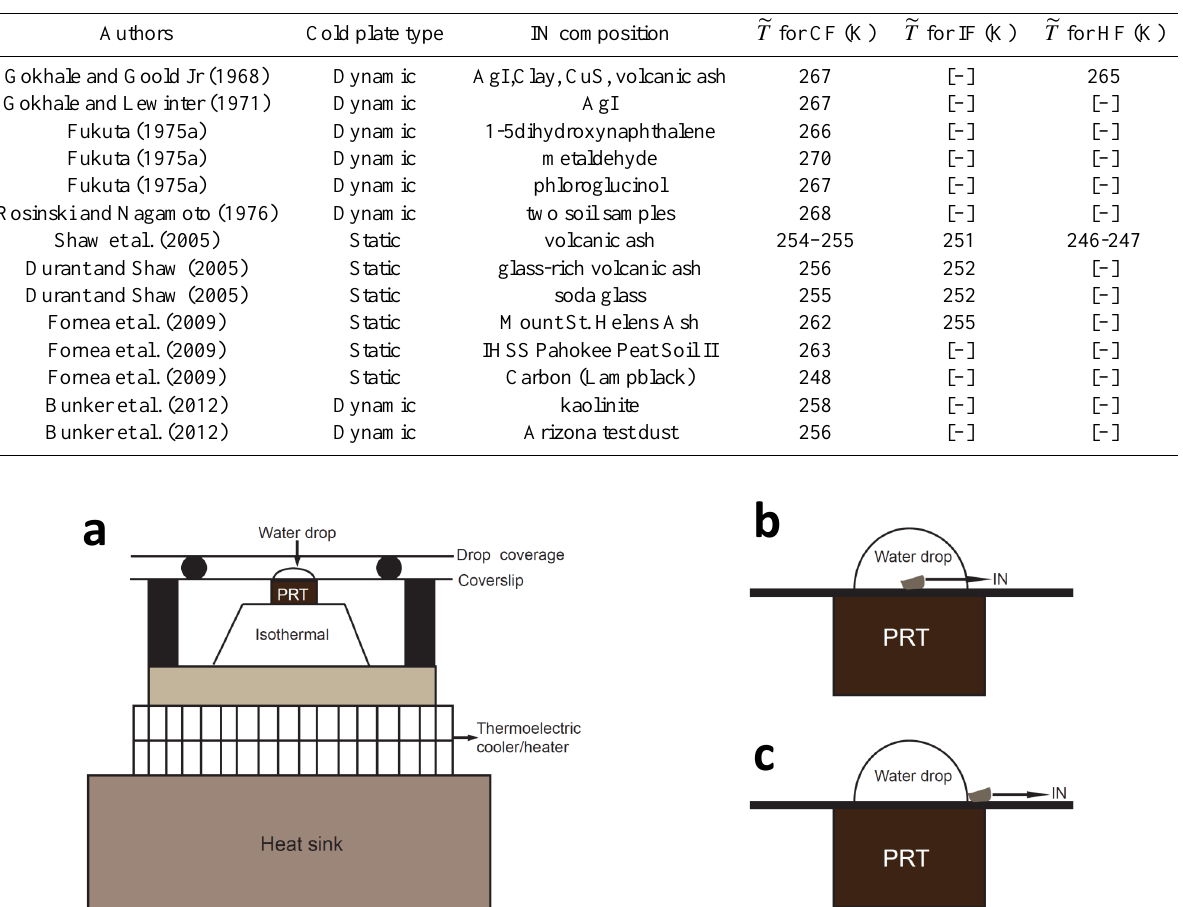
Table 2. Summary of the freezing temperatures for contact and immersion freezing conducted on a cold plate. e T is the average onset freezing temperature (temperature at which the tested drops freeze) for contact freezing (CF), immersion freezing (IF) and homogeneous freezing (HF), respectively.